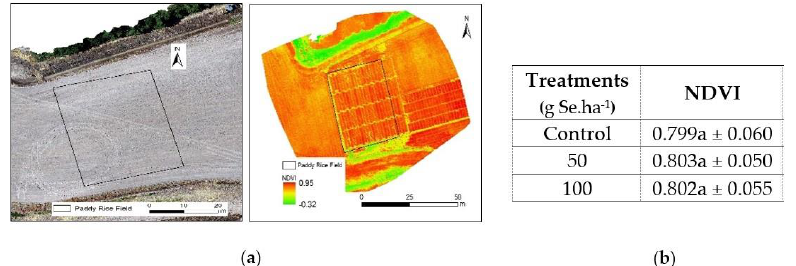
Figure 1. Orthophotomap and normalized vegetation index (NDVI) obtained from images of UAV’s ( n = 12) of Oryza sativa (Ariete variety) after the 2nd application of 50 and 100 g Se · ha − 1 sodium selenite ( a ). Mean values of NDVI ± standard deviation ( b ). Information collected at 12 September 2018. Letter a indicate the absence of significant differences among treatments ( p ≤ 0.05).